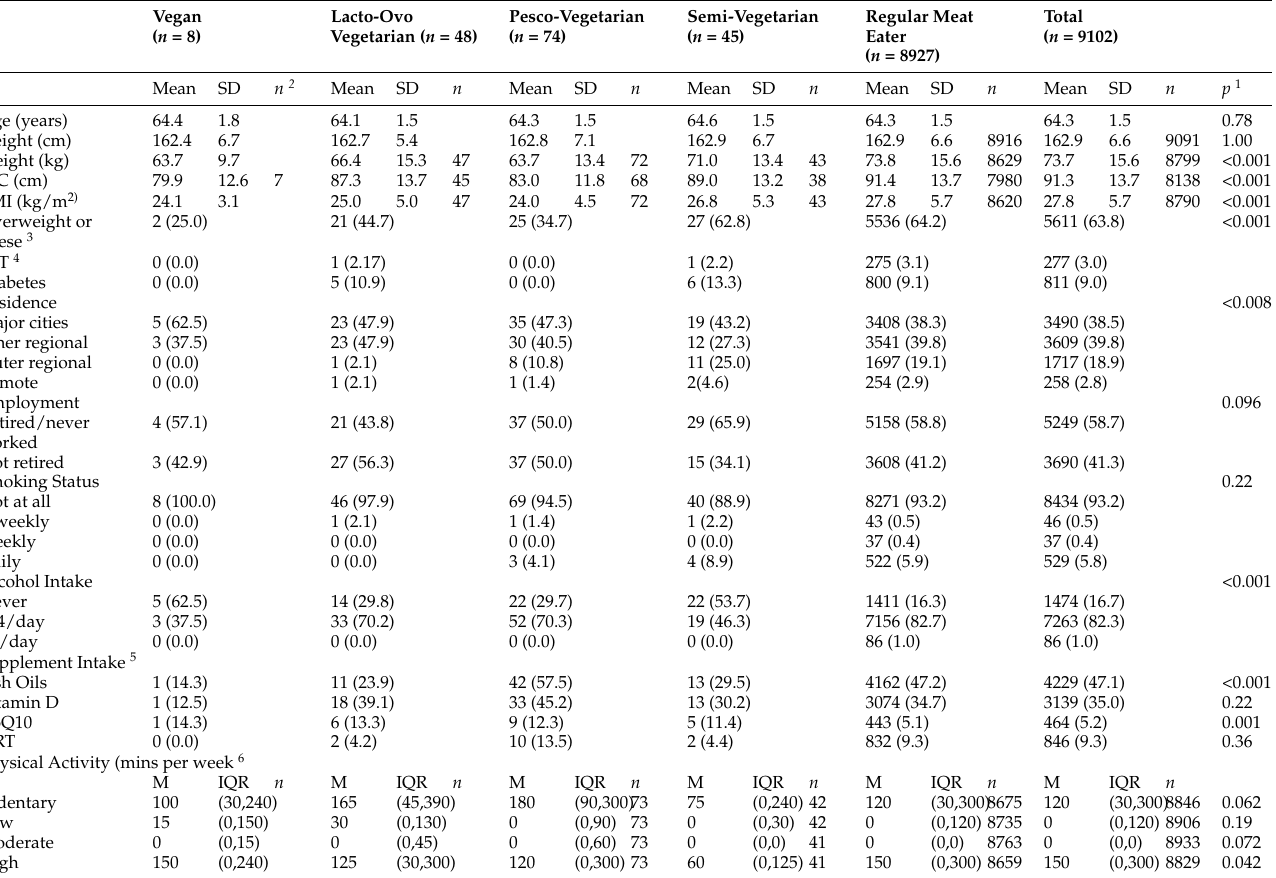
Table 2. Characteristics of all study participants of the 1946–51 aged cohort of the Australian Longitudinal Study of Women’s Health at Survey 7 (in 2013). Data are presented as mean and standard deviation or counts and (percentages) unless otherwise